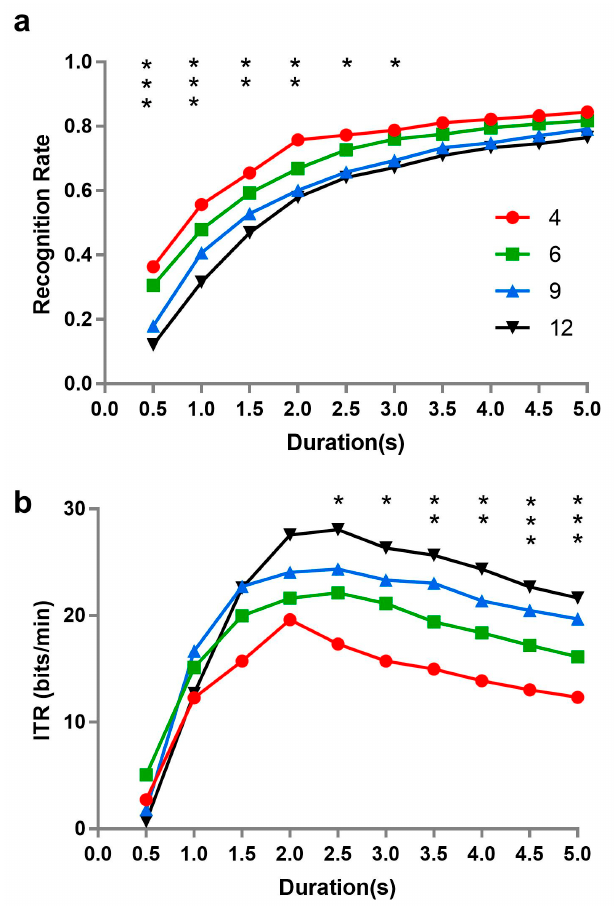
Figure 6. The performance of SSVEP-based brain–computer interface (BCI) for di ff erent numbers of stimuli and time lengths: ( a ) recognition rate, and ( b ) information transfer rate (ITR). The asterisk “*” indicates a significant difference among different stimulus numbers (i.e., * p < 0.05, ** p < 0.01, *** p < 0.001).